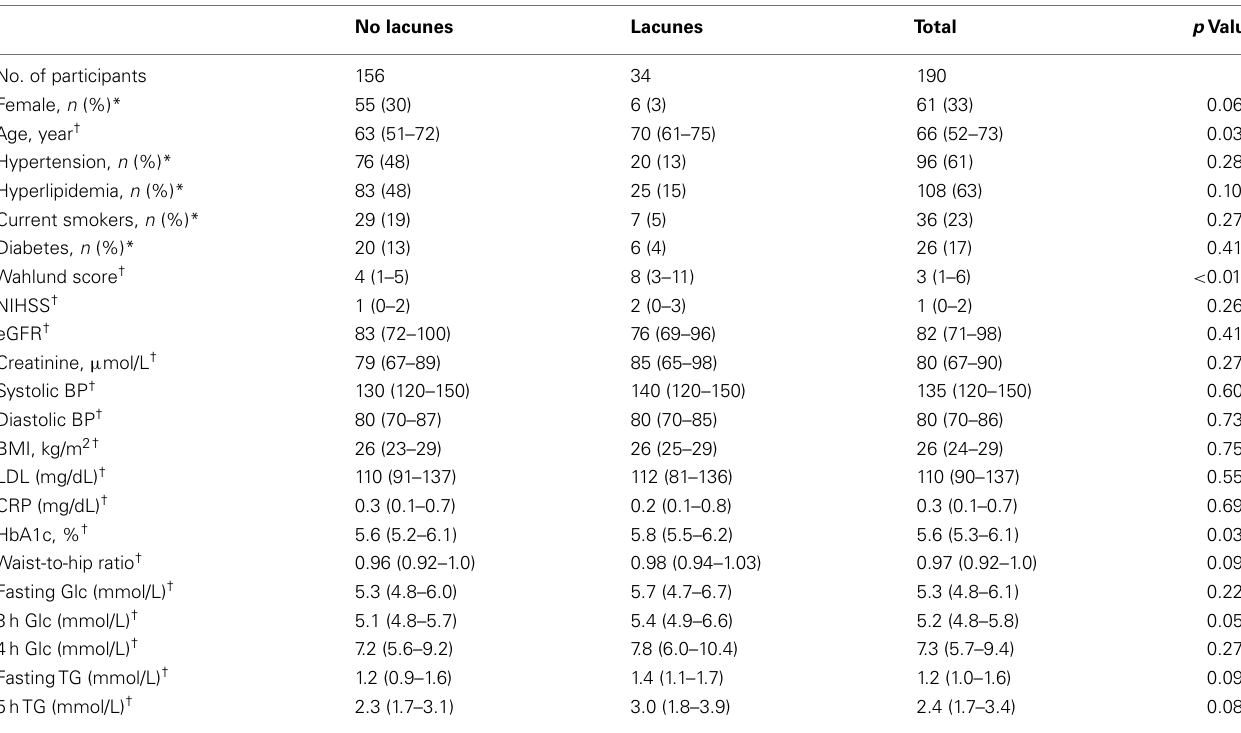
Table 1 | Demographic characteristics according to presence of cavitating lacunes.